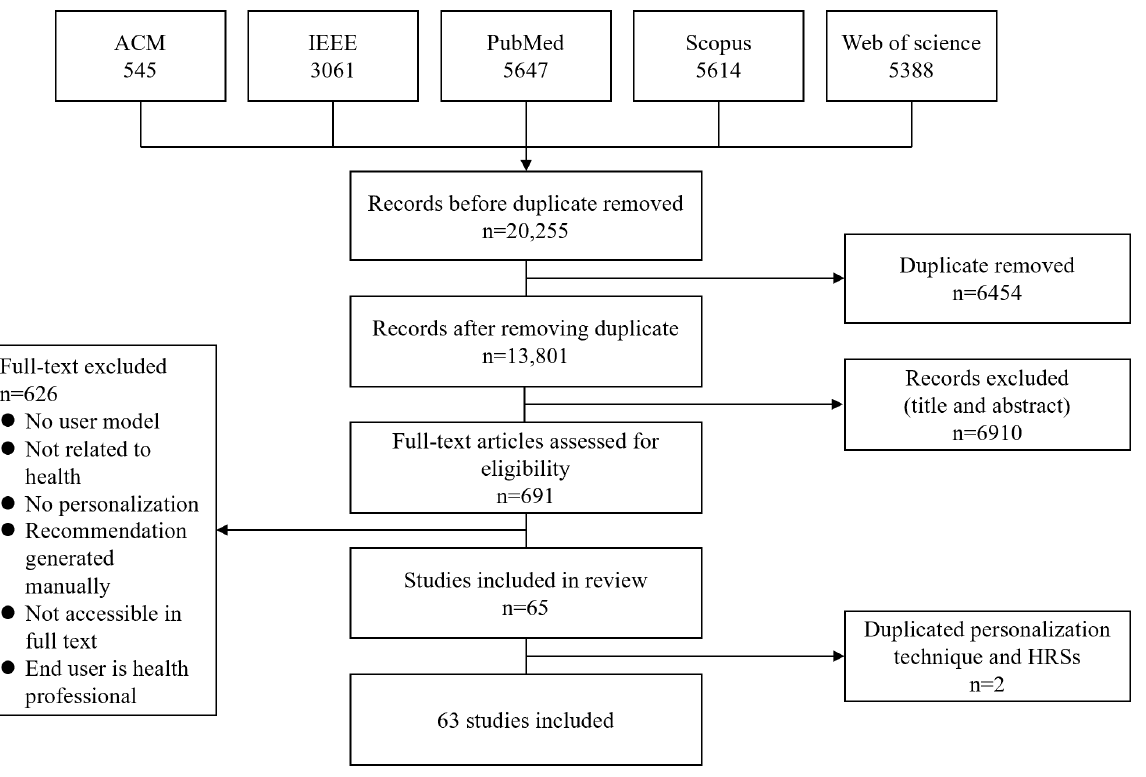
Figure 1. Study identification and